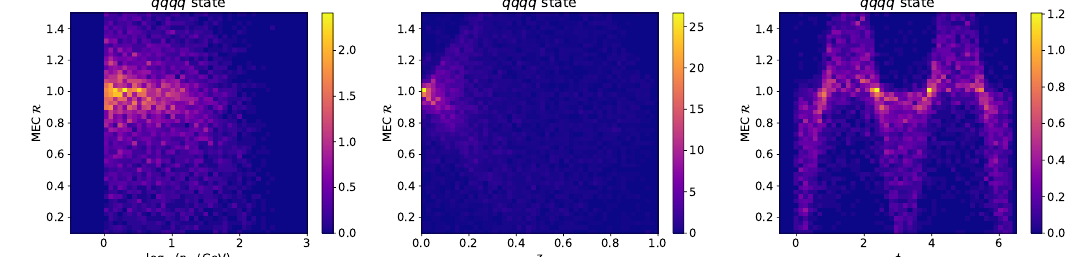
Figure 5: Consistency validation of qq ¯ q ¯ q state. For small transverse momenta, the correction is centered around one. An azimuthal dependence of the correction can be seen, correcting the averaged emission pattern of the shower.